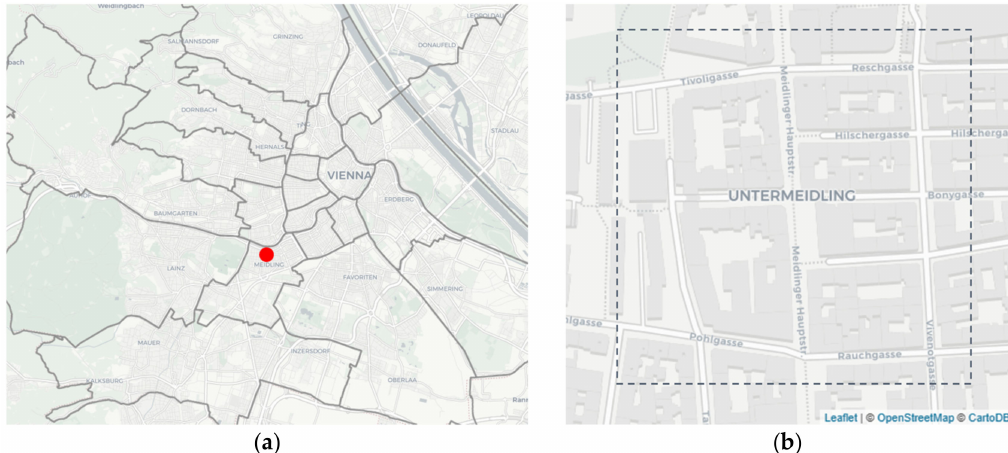
Figure 1. Case study domain in the city of Vienna: ( a ) position within Vienna’s 12th district Meidling; ( b ) detail map of the study area (Source: open street map,